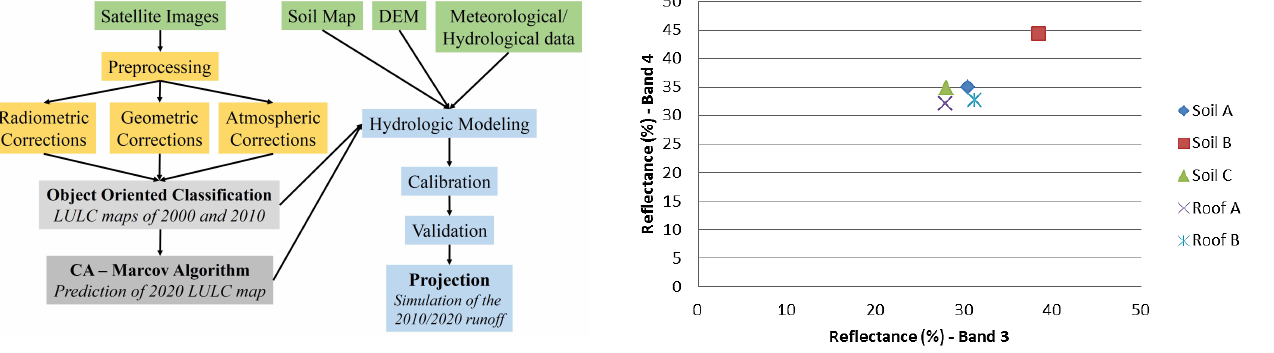
Fig. 3. Scatterplot for the different targets for bands